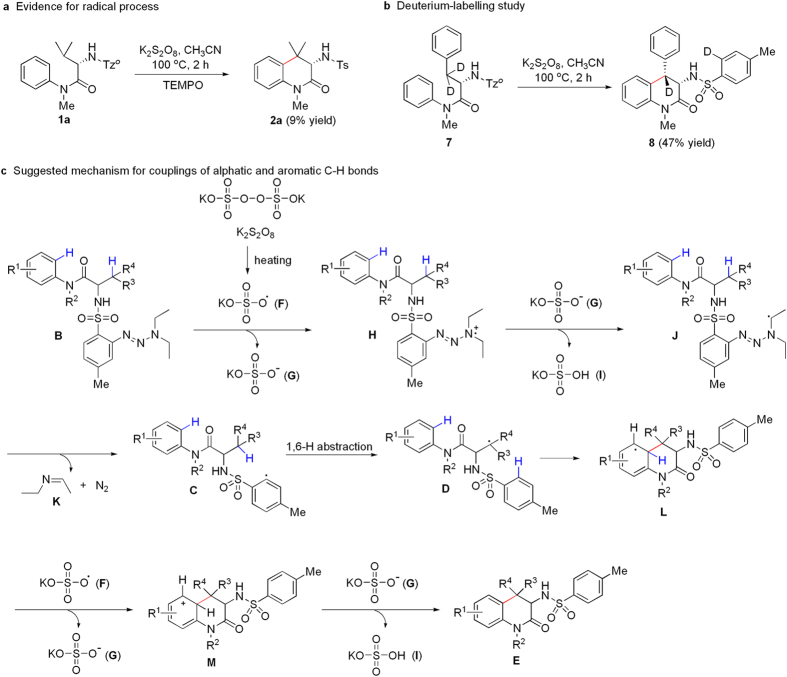
Mechanistic investigations.(a) Evidence for the in situ formation of an intermediate aryl radical. (b) Deuterium-labelling study to support a H-abstraction event during coupling of alphatic and aromatic C-H bonds. (c) Proposed reaction mechanism for couplings of alphatic and aromatic C-H bonds.